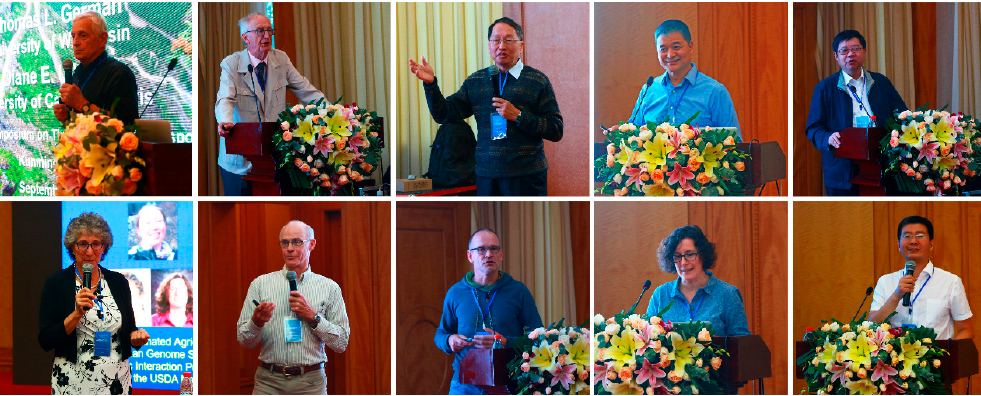
Figure 2. Representatives from all over the world gave presentations on the XIth International Symposium on Thysanoptera and Tospoviruses.